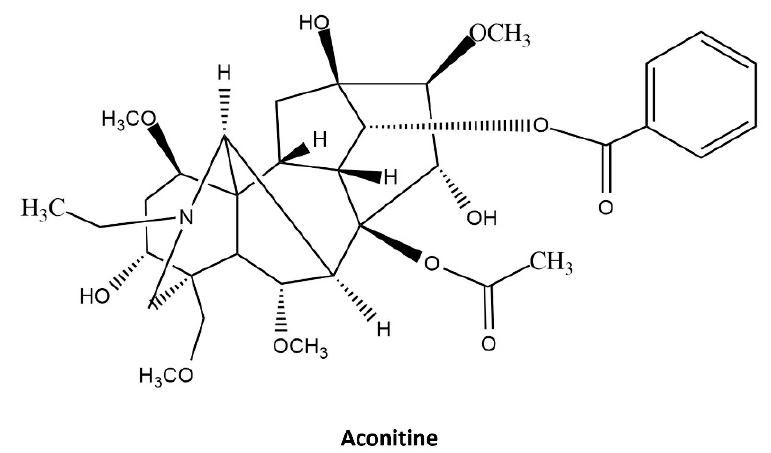
Figure 1. Structure of Aconitine.